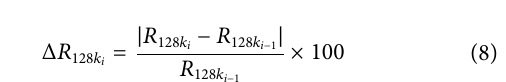
Frontiers in Electronics |